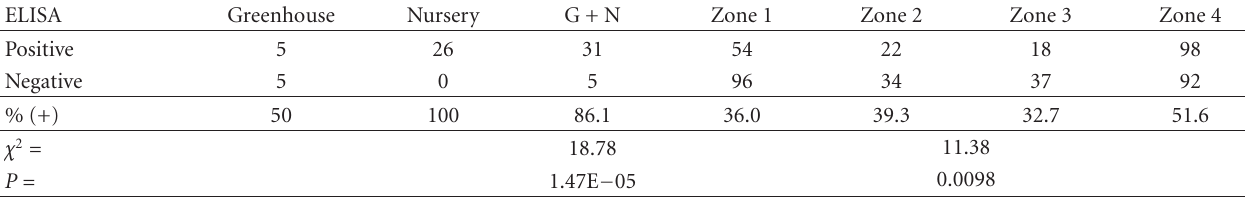
Table 1: Results from ELISA test for Phytophthora capsici on chili pepper plant samples from greenhouses, nurseries, and farms located in four geographical zones in the northern area of Aguascalientes, Mexico.